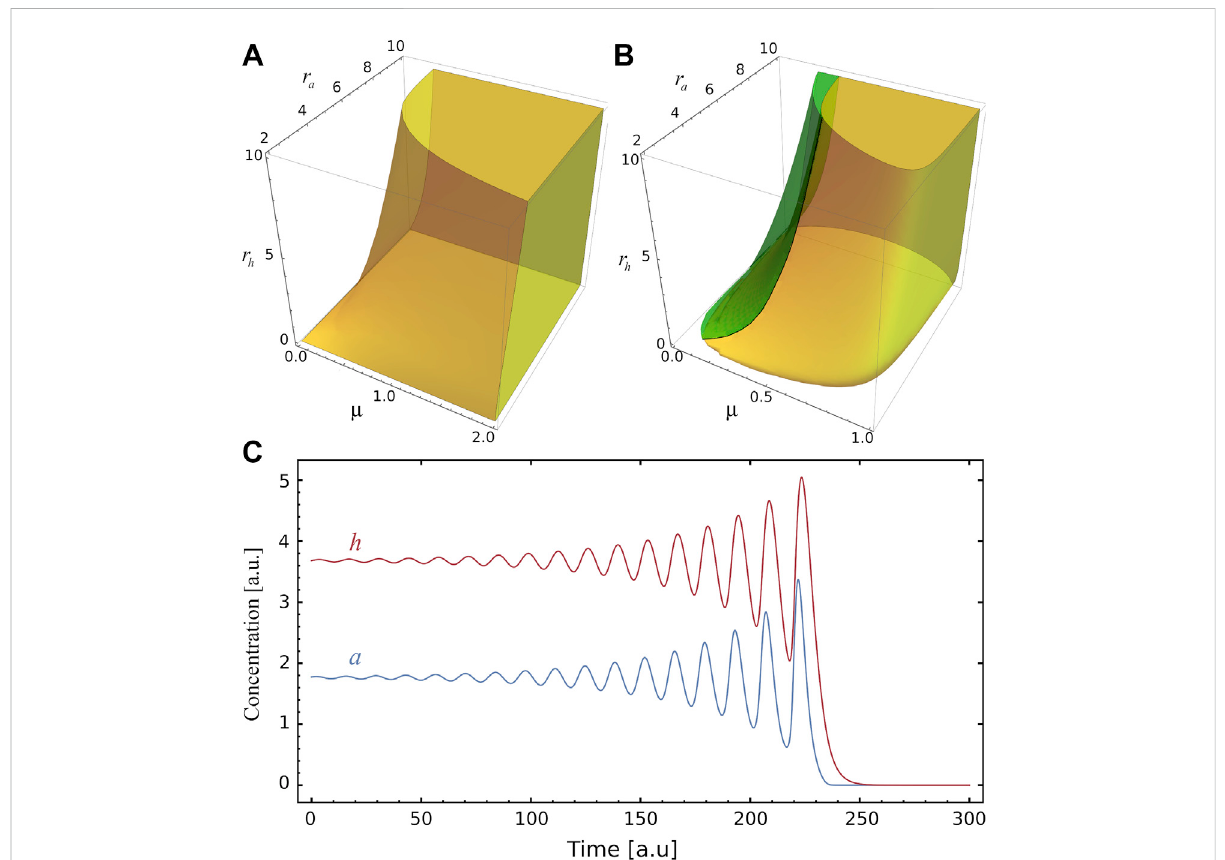
FIGURE 2 Stability and instability of the fi xed point S 2 . (A) Yellow volume delimits, inthe parameters space ( μ , r a , r h ), the region where the steady state S 2 is stable. (B) The green region corresponds to the values of the parameters where the system develops a spiral source behaviour in the steady state S 2 (see panel C), whileinthe yellow region there isa spiral sink behaviourat S 2 . Only at theinterface of these two regions does thesystem exhibitalimit cycle. (C) Exampleillustrating ofunstableoscillatorybehaviourfor a and h ,asfunctionoftime,for( μ , r a , r h )=(0.24,10,5),theamplitudesincrease until they reach the stable trivial fi xed point S 0